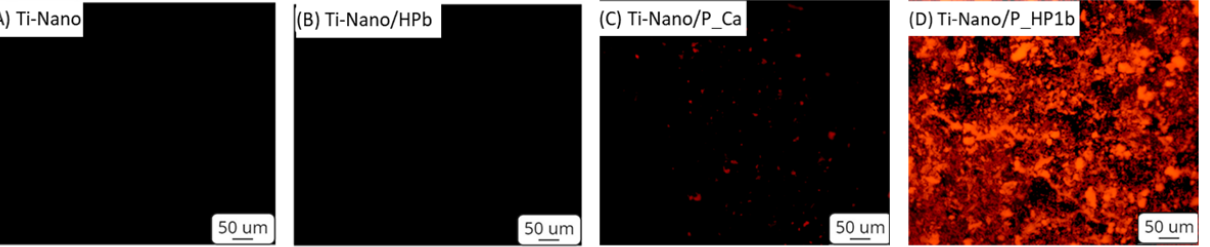
Figure 3. Fluorescence images of Ti-Nano ( A ), Ti-Nano/HPb ( B ), Ti-Nano/P_Ca ( C ), and Ti- Nano/P_HP1b ( D ); filter: 540 nm.